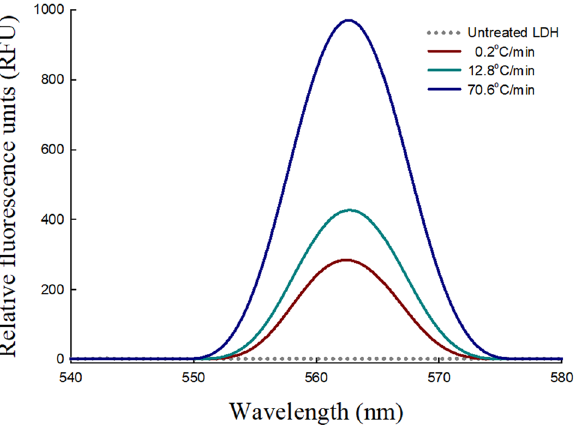
Figure 6. Intrinsic fluorescence emission spectra (540–580 nm) of 20 μg/mL LDH in 0.2 M Tris–HCl buffer (pH 7.4) after the freeze–thaw process was repeated five times. LDH solution was frozen at a freezing rate of 0.2, 12.8, or 70.6º C/min. The frozen samples were thawed in a water bath at 25 ºC for 5 min before